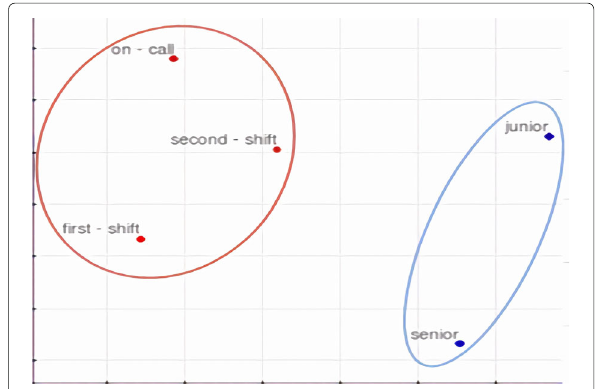
Fig. 7 Example of clusters obtained with DBSCAN. Red cluster represents a value space of an attribute potentially named working_hours while the blue cluster contains value of an attribute potentially named